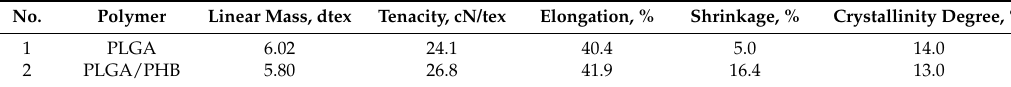
Table 1. Characteristic of the fibres used for manufacturing of the implants.